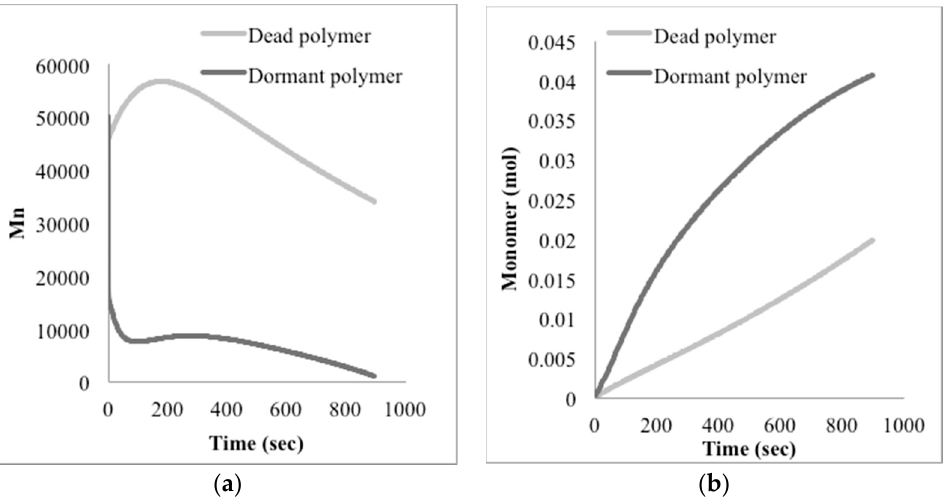
Figure 12. ( a ) M n evolution, and ( b ) monomer generation for the pyrolysis of dead and dormant polymer predicted by the model with the base set of kinetic constants of Table 5.